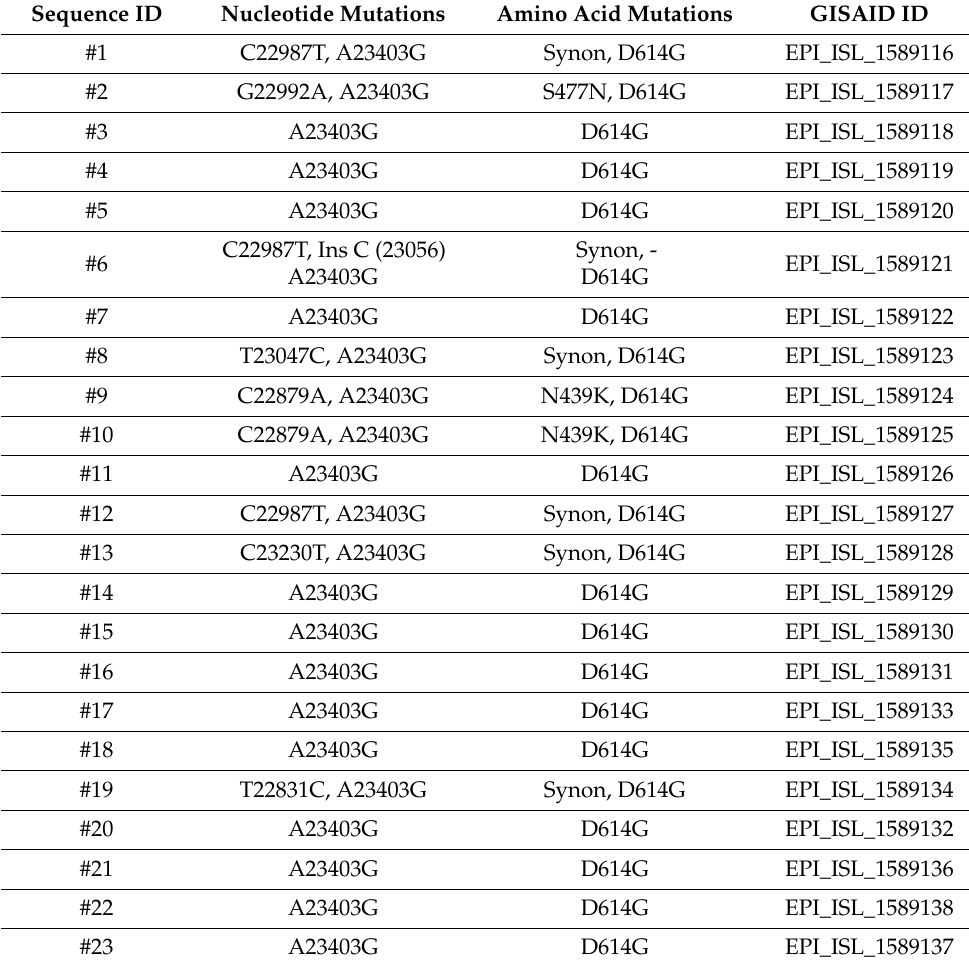
Table 3. SARS-CoV-2 RBD sequence analysis of enrolled children, with GISAID